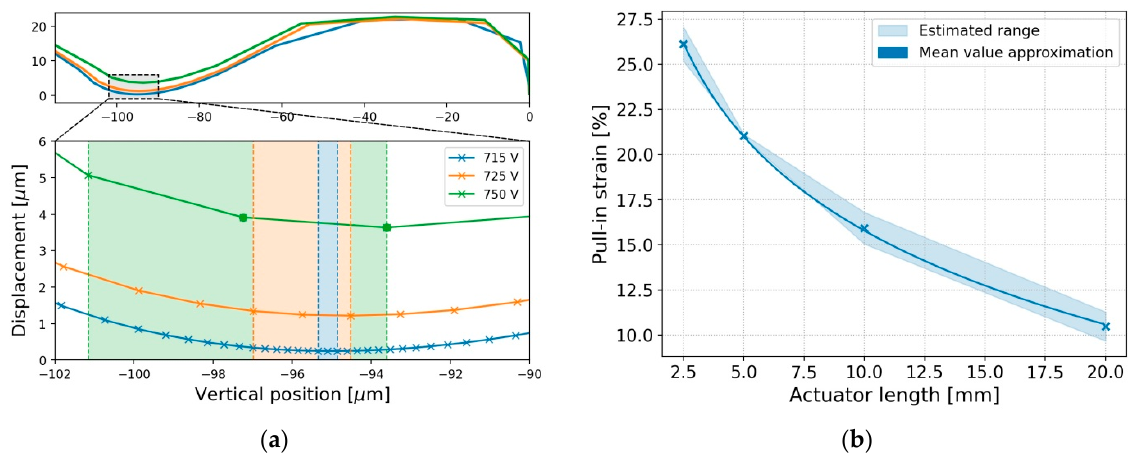
Figure 6. ( a ) Methodology for estimation the pull-in strain value of the actuator; ( b ) Length—pull-in strain characteristic for actuator of the length 2.5 mm, the width 4 mm and initial deflection 10%.